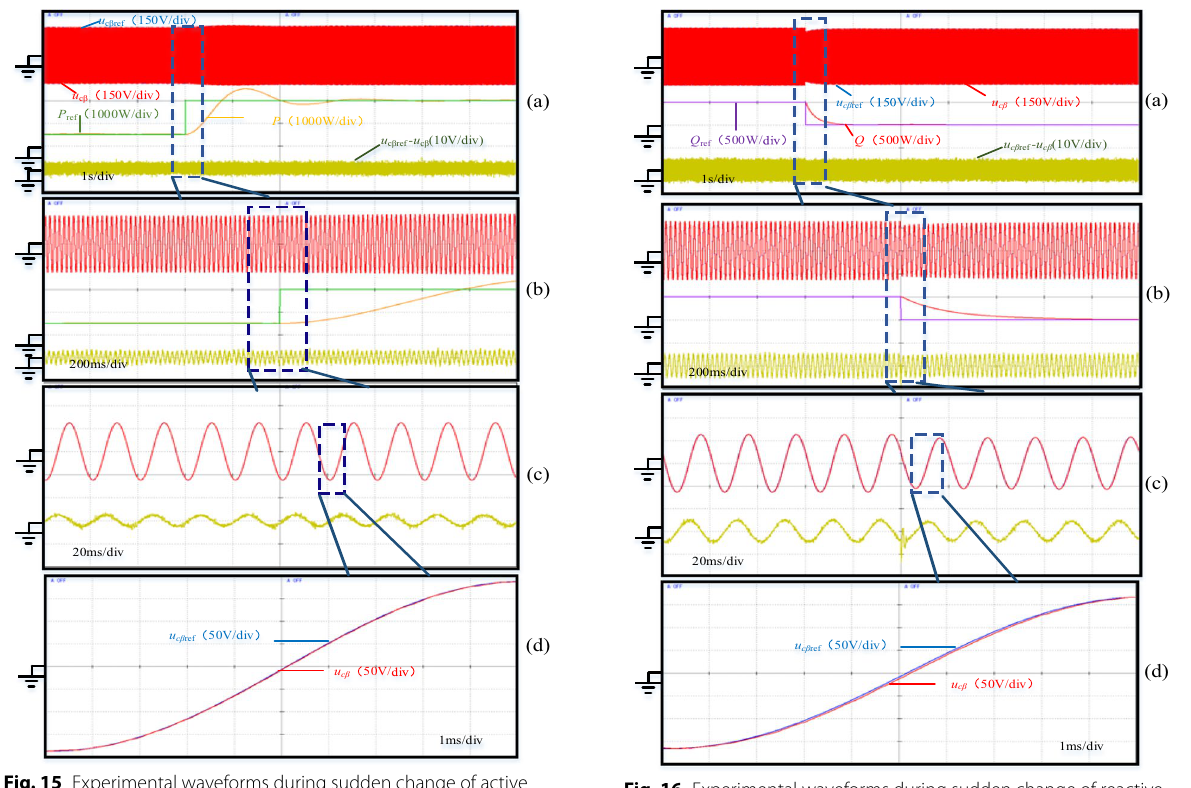
Fig. 16 Experimental waveforms during sudden change of reactive power without error compensation. a 1 s/div. b 200 ms/div. c 20 ms/ div. d 1